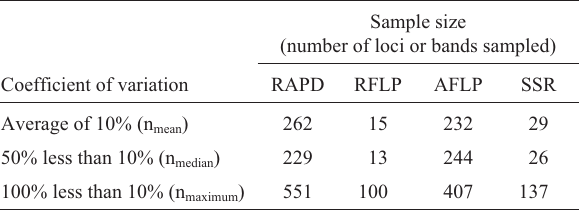
Table 3 - Sample size (number of loci or bands) required so that genetic distance values will have the specified coefficient of variation values. Sample size (number of loci or bands